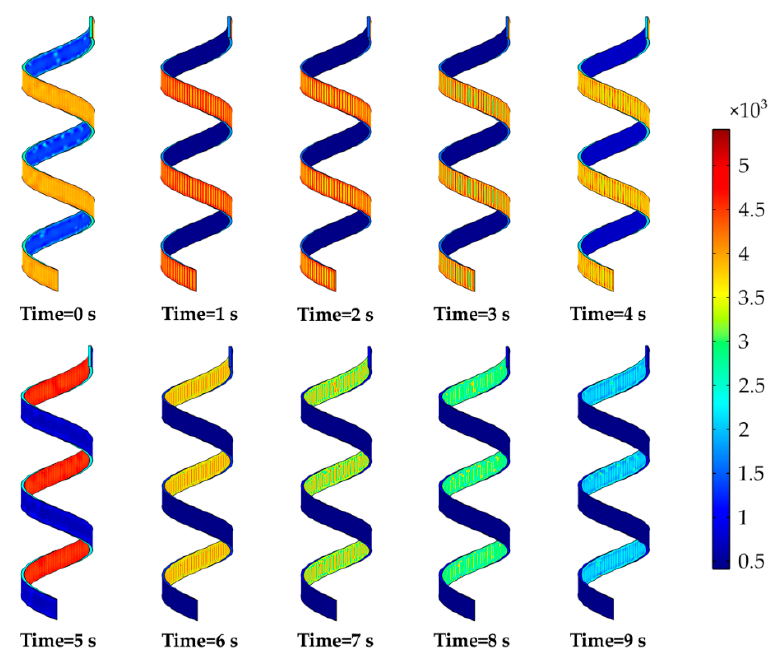
Figure 16. Concentration distribution of the mobile ions.